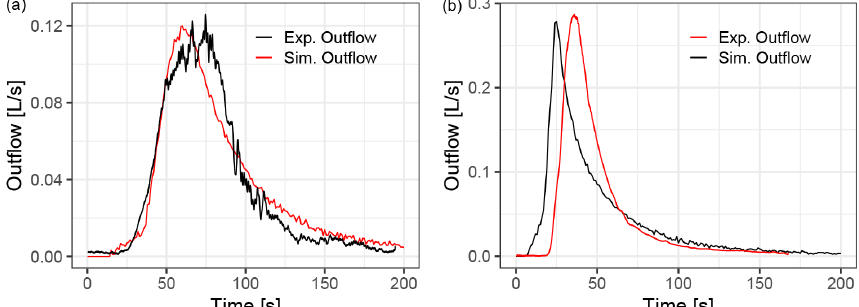
Figure 12. Simulated hydrographs compared to experimental data from Cea et al. (2010a) for two rainfall pulses on the A12 building